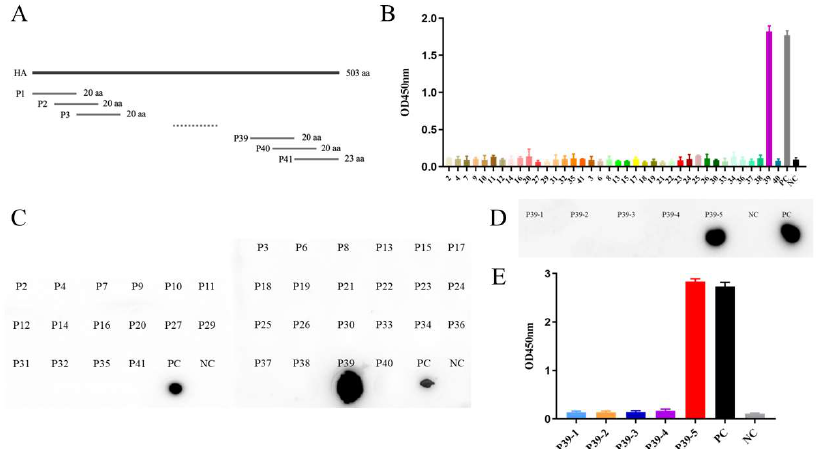
Figure 4. Identification of the B cell linear epitope on HA protein. ( A ) A schematic diagram of 41 overlapping peptides containing 20–23 amino acids (containing an offset of 7 aa) of HA protein (residues 19–521). ( B ) Reactivity of 41 overlapping peptides with mAb 6H2 detected by ELISA. ( C ) Dot blotting analysis of 41 overlapping peptides reacted with mAb 6H2. ( D ) Dot blotting results of five truncated peptides reacted with mAb 6H2. ( E ) ELISA results of five truncated peptides recognized by mAb 6H2. PC, recombinant HA protein diluted in peptide diluent. NC, peptide diluent.